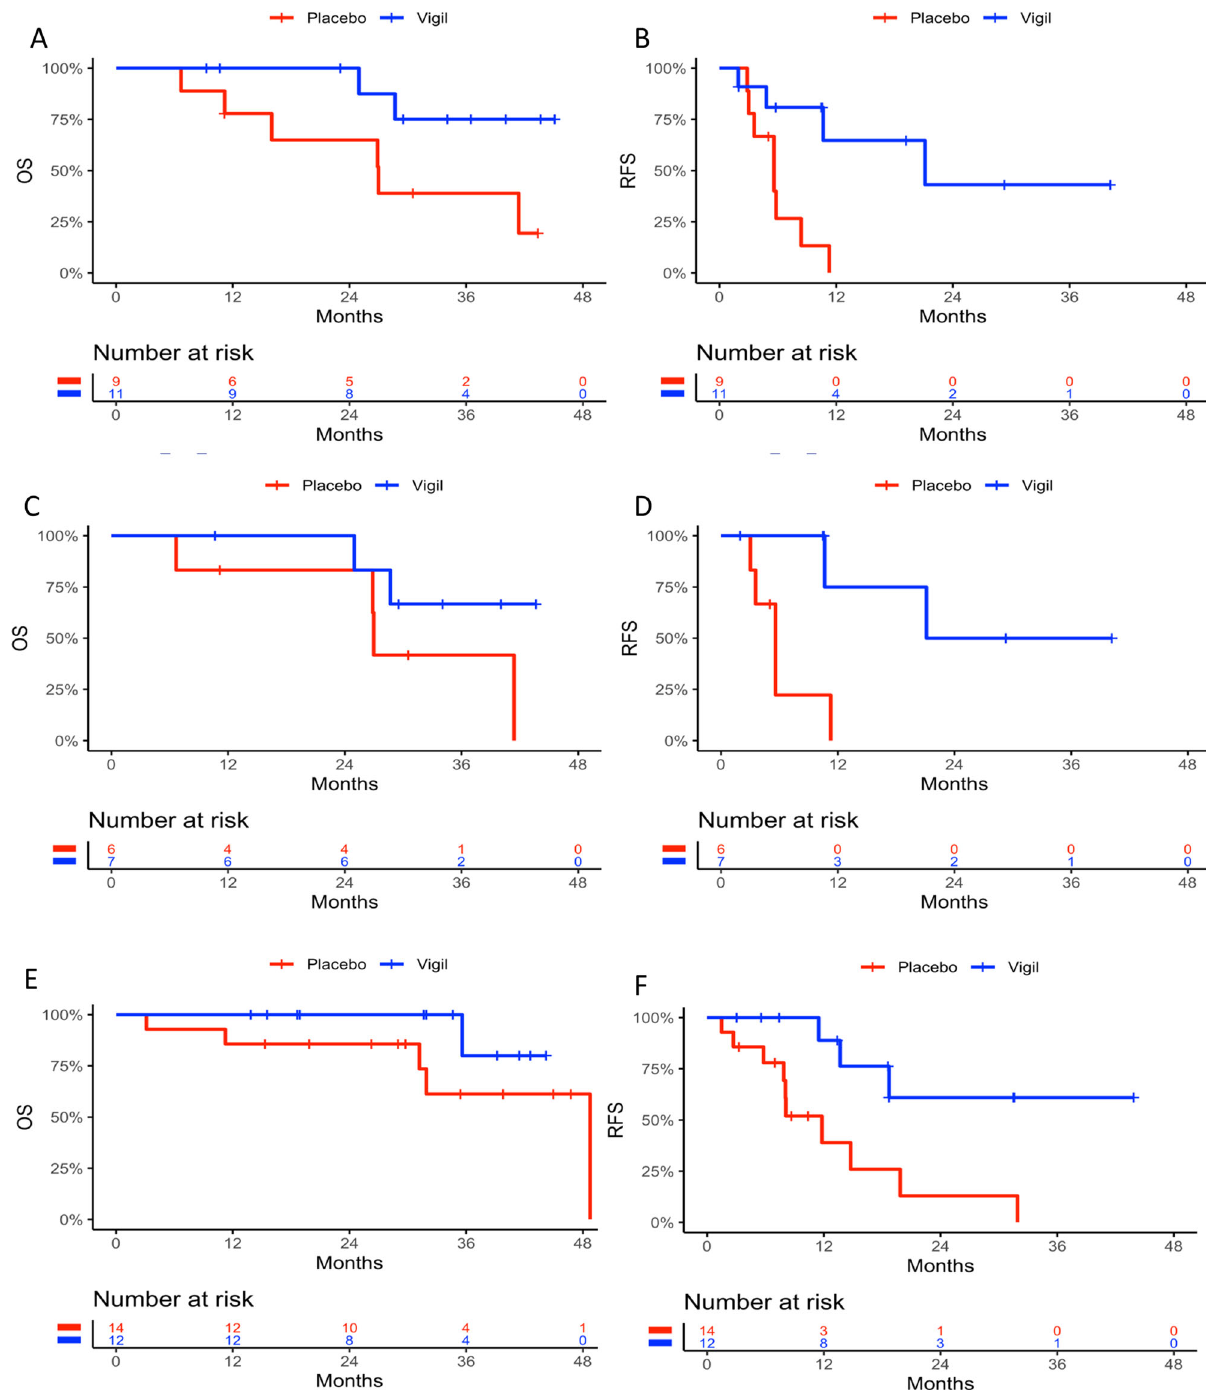
Fig. 5 Strati fi cation of patient population by homologous recombination and p53 mutation status. Kaplan Meier (KM) curves of ENTPD1/CD39 ≥ median expression in Vigil ( n = 11) versus placebo ( n = 9) patients for overall survival A and Relapse free survival B in the homologous recombination pro fi cient (HRP) population. HRP, p53 mutant with high ENTPD1/CD39 expression KM curves in Vigil ( n = 7) versus placebo ( n = 6) are presented for overall survival C and relapse free survival D . KM curves of homologous recombination de fi cient (HRD) patients with high ENTPD1/CD39 expression in Vigil ( n = 12) versus placebo ( n = 14) for overall survival E and relapse free survival F . P values are one